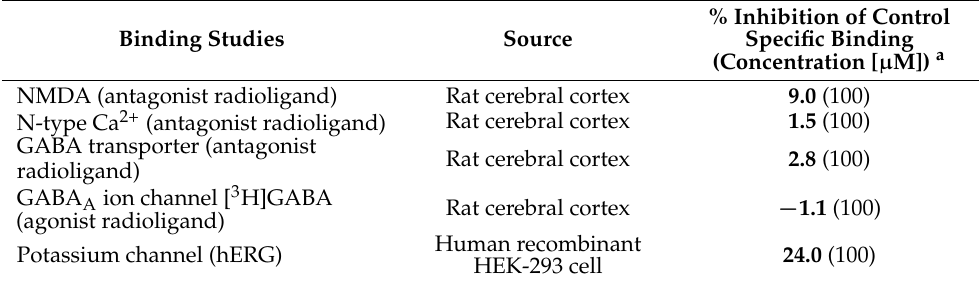
Table 5. Additional in vitro binding assays for 53 . Binding